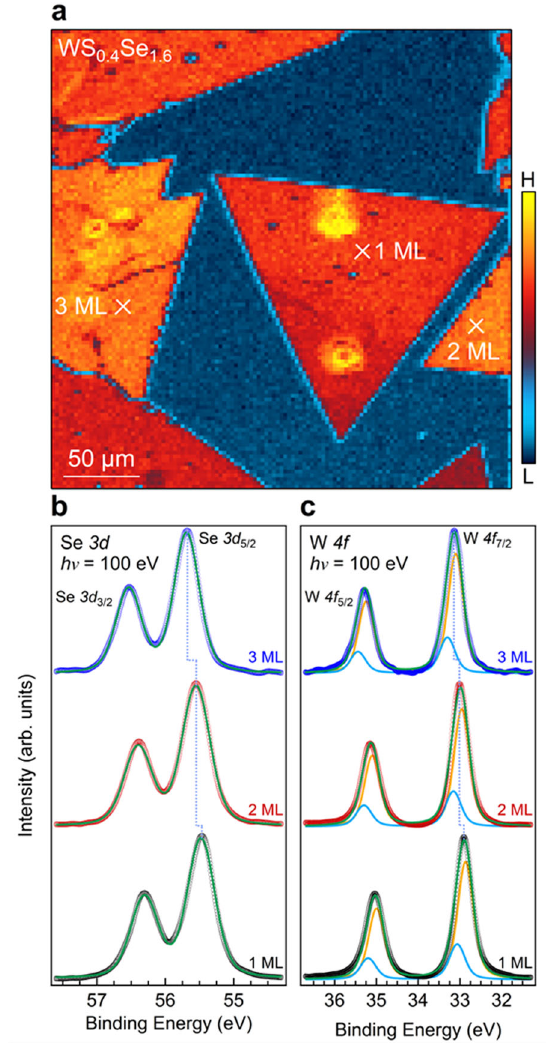
Fig. 3 Nano-XPS maps of the WS 2(1 − x ) Se 2 x ( x = 0.8) sample. a Spatially resolved photoemission map (of 300 × 300 μ m 2 area) of the Se 3 d core level obtained from the WS 2(1 − x ) Se 2 x ( x = 0.8) sample by using a photon energy of 100 eV. b , c Left (Right) panel corresponds to the μ -XPS spectra of the Se 3 d (W 4 f ) core level acquired on three distinct points represented as crosses in panel ( a